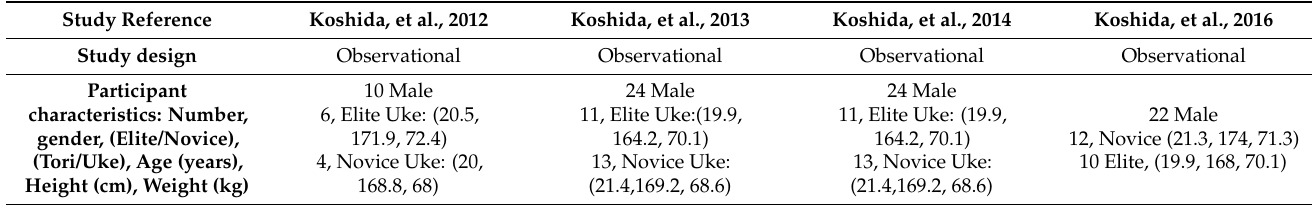
Table 3. Study characteristics and